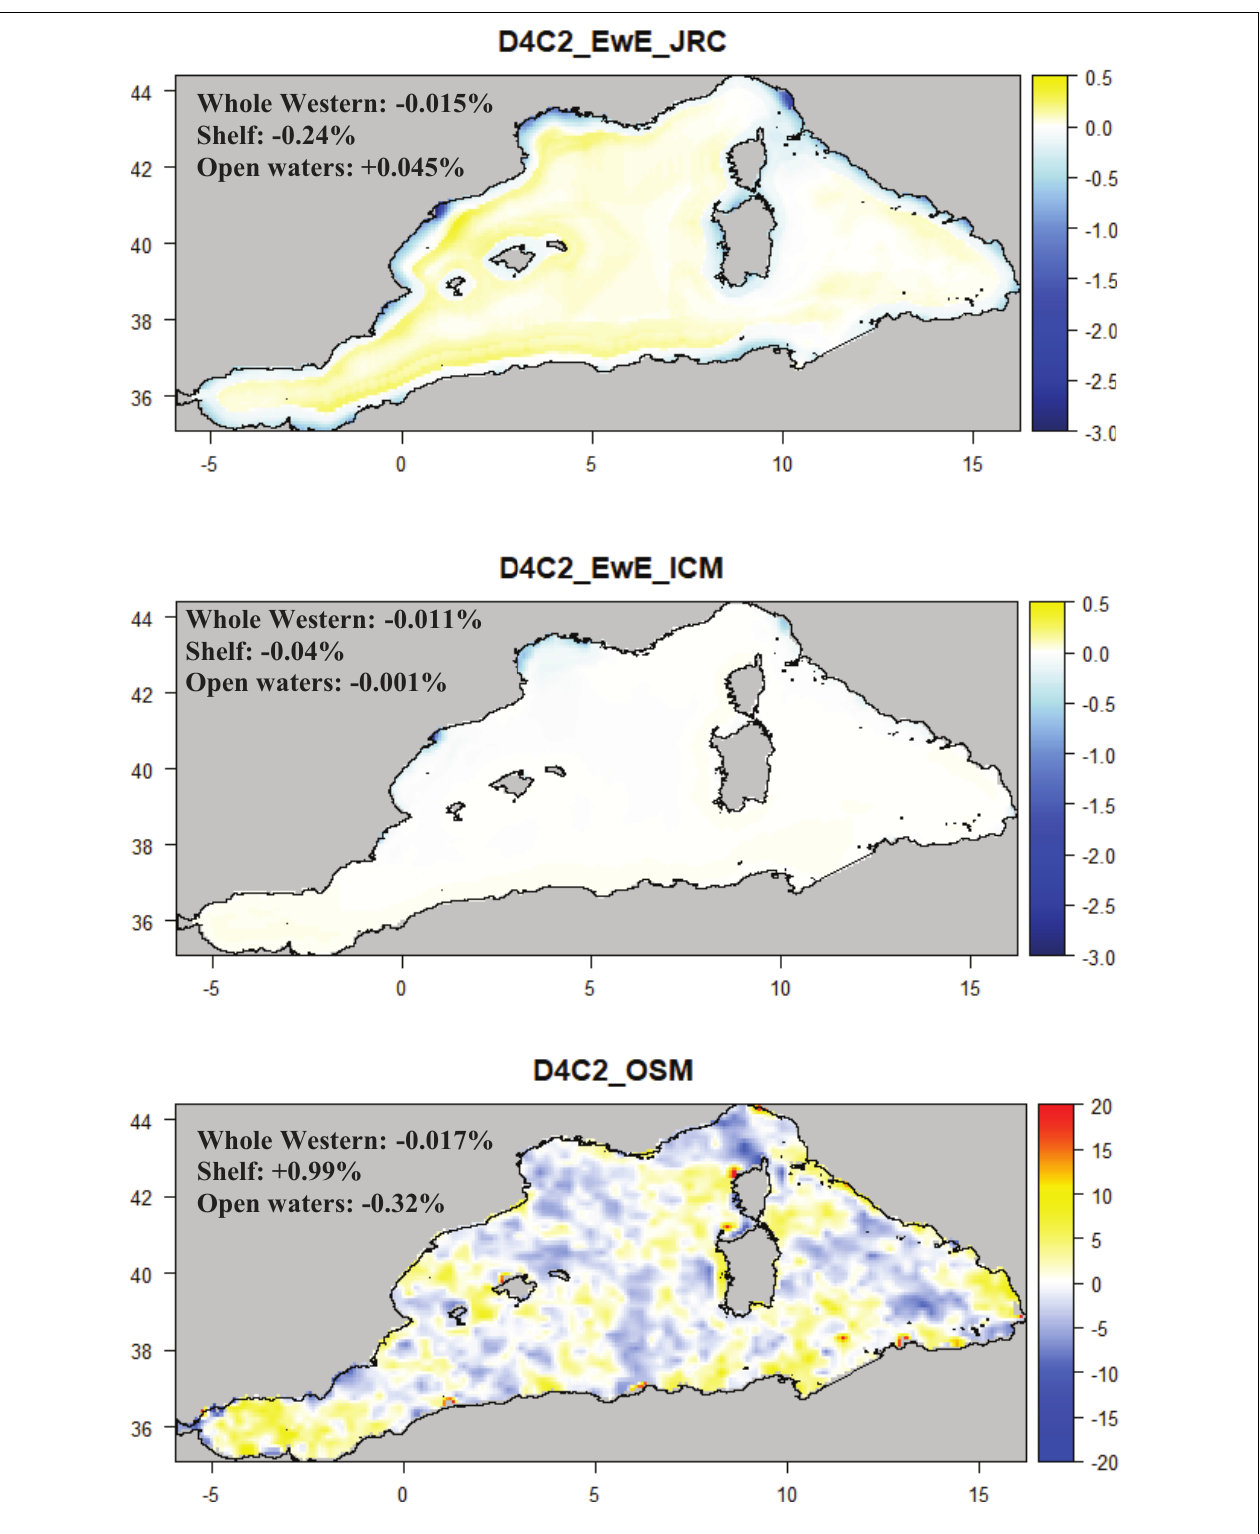
FIGURE 5 | Maps representing the mean change (%) for the Small pelagic fish biomass (D4C2) per model type. Mean values were calculated considering the whole Western sub-region, shelves ( < 200 m) and open waters ( > 200 m). Note that the color scale of D4C2_OSM is different from the one of D4C2_EwE_JRC/ICM.